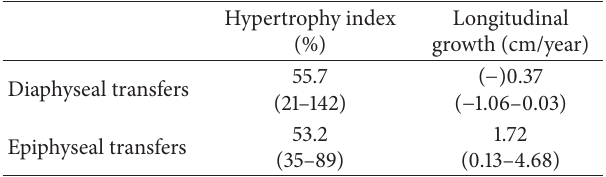
Table 3: Measures of